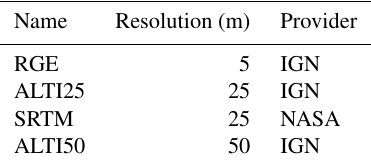
Table 2. DEMs resolution and